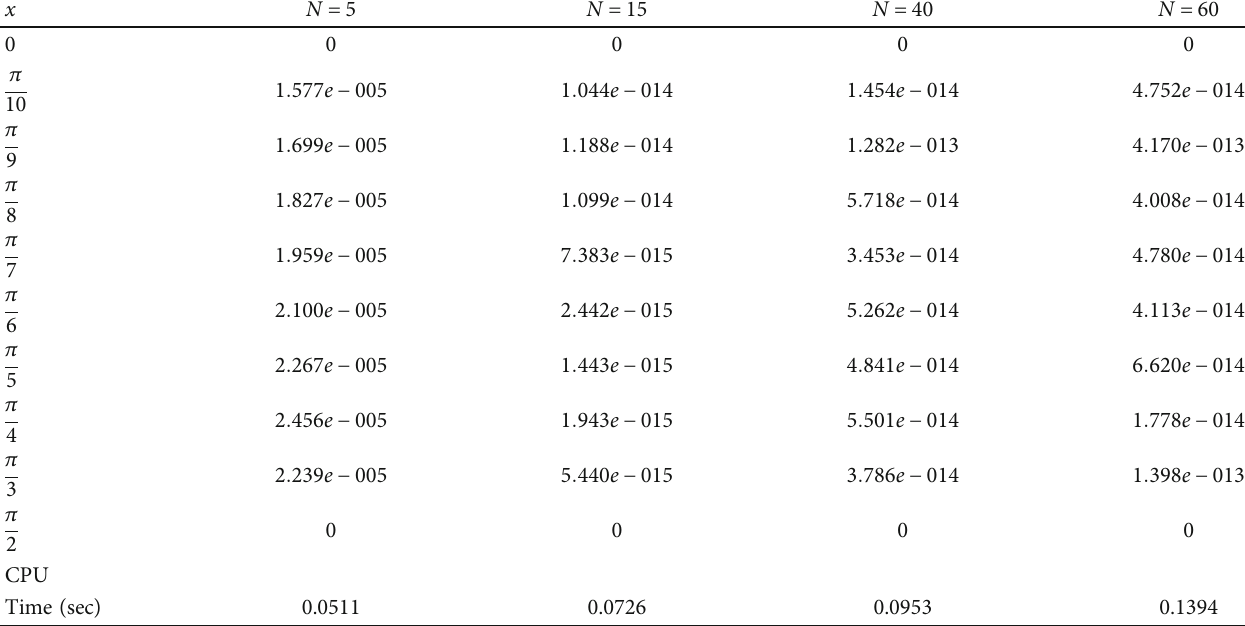
Table 2: Maximum absolute errors of Example 2 for di ff erent values of x and N .